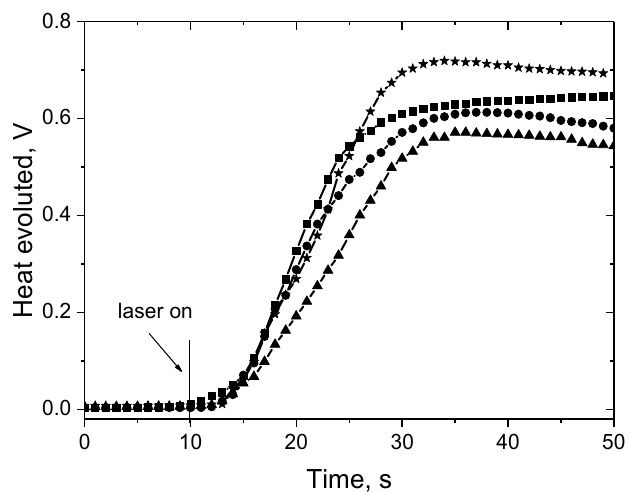
Figure 9. Family of kinetic curves recorded during the measurements of the heat flow emitted during the photoinitiated polymerization of the TMPTA-MP mixture initiated by tested dyes—[(3,4-dimethoxyphenyl)sulfanyl]acetic acid couples. The co-initiator concentration was 0.1 M, and the light intensity of the diode laser (408 nm) was 18 mW/cm 2 . The applied dyes possessed various chromophores: ■ —FN2, ⁎ —FN12, ● —FN8, ▲ —FN13.